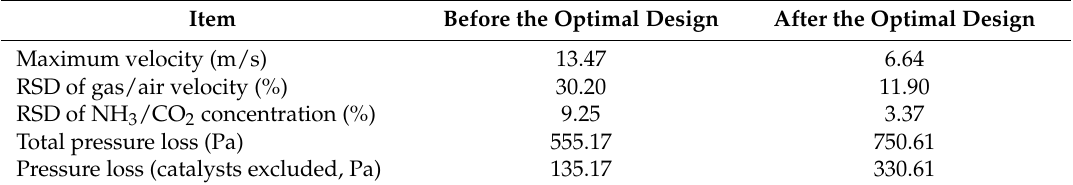
Figure 12. The influence of the crossed baffles on gas velocities and NH 3 concentration. Table 1. Comparisons between the statistic indices before and after the optimal